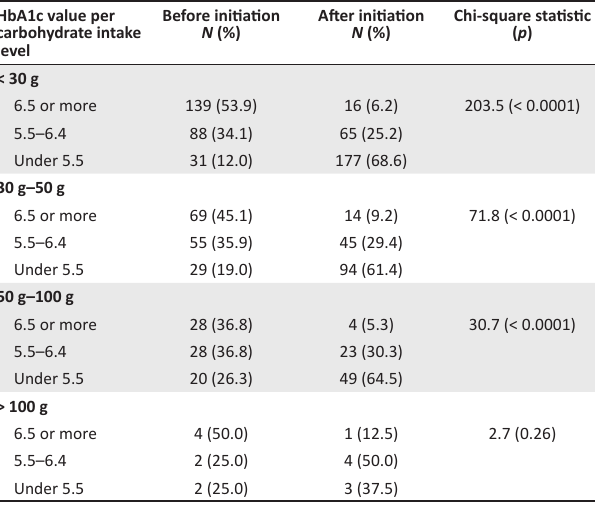
TABLE 5: HbA1c values stratified by carbohydrate